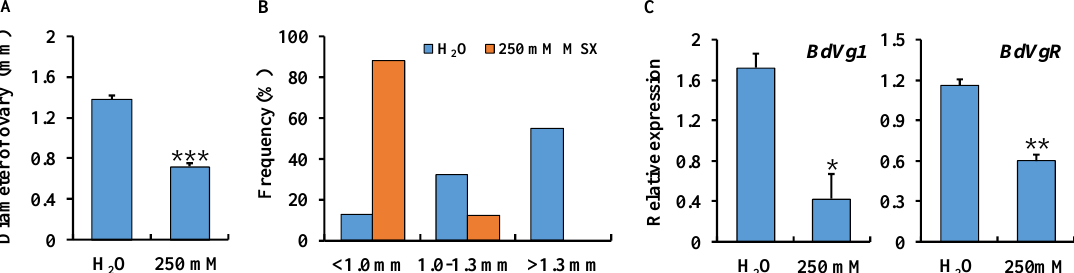
Figure 5. Gene expression of BdGSm ( A ) BdGSc ( B ) and enzymatic activity of glutamine synthetase ( C ) in Bactrocera dorsalis after feeding on the MSX inhibitor. Gene expression was calculated by qBase Plus software. The bar represents the mean gene expression and the error bar represents the positive standard error of the mean. A di ff erent letter on the bar indicates a significant di ff erence analyzed by one-way analysis of variance with a Tukey LSD test using SPSS 19.0 ( P < 0.05). To confirm that enzyme inhibition suppresses ovarian development, we dissected the ovaries of females fed on a high dose of MSX and measured their sizes. The ovarian diameter size of the MSX-fed females was significantly smaller than that of the control ( P < 0.001, Figure 6A). The frequency of each subcategory differed between treatment and control group (Figure 6B). Similar to the RNAi assay, most of the ovaries in the control group were >1.0 mm, while in the MSX group, most of the ovaries were <1.0 mm. The gene expression of a vitellogenin ( BdVg1 ) and vitellogenin receptor ( BdVgR ) was detected, and strong suppression of both BdGSs genes was observed in the high-dose MSX treatment group (Figure 6C).